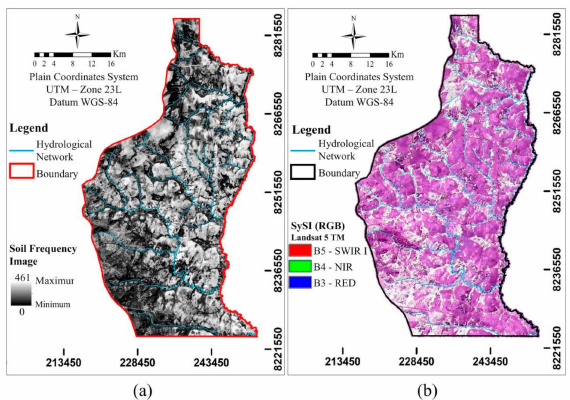
Figure 7. ( a ) Soil frequency image of the Landsat time series and ( b ) synthetic soil/rock image.